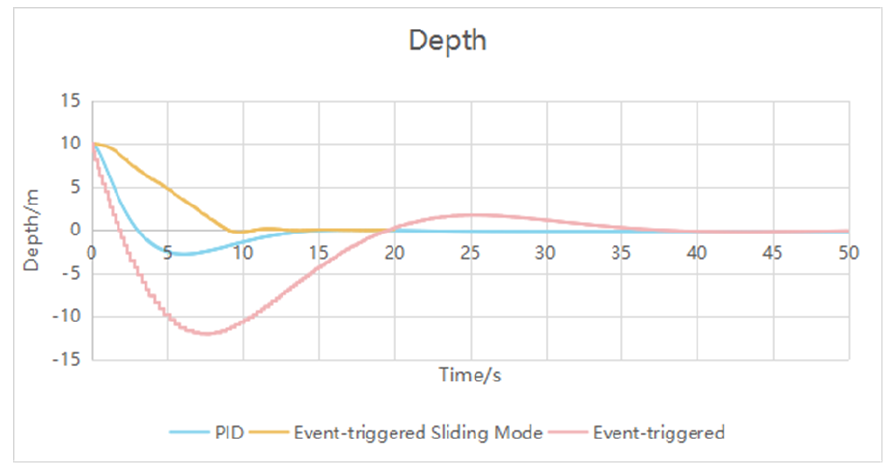
Figure 9. Comparison diagram of three control algorithms.